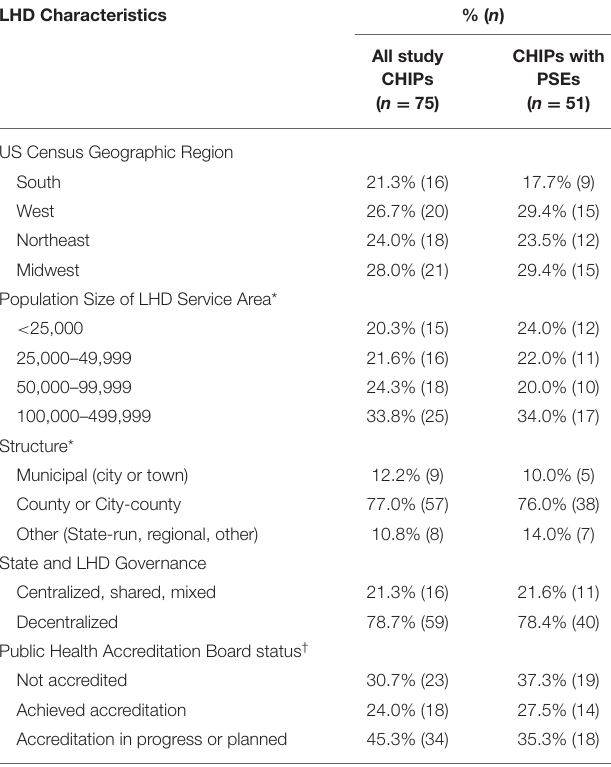
TABLE 2 | Characteristics of LHDs participating in the development of a CHIP among all study CHIPs ( n = 75) and CHIPs with at least one policy, systems, or environmental healthy eating or physical activity strategy ( n = 51).